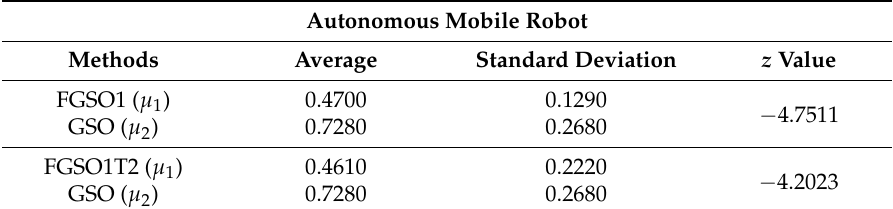
Table 6. Results for the z test with FGSO1, FGSO1T2 and the GSO with